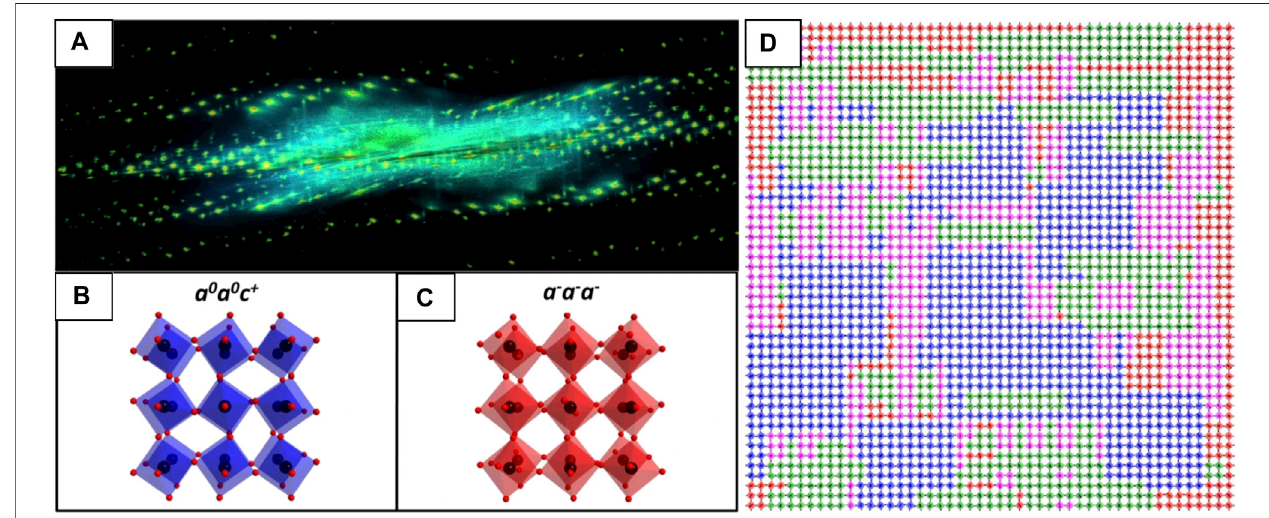
FIGURE 10 | 3D-ED mapping of Bragg and diffuse electron scatter in reciprocal-space to determine TiO 6 octahedral tilt schemes in 85NBT-10BKT-5BT [001] pc ceramic. (A) Reconstruction of the reciprocal-space volume showing intensity from both Bragg and diffuse scattering. (B) Schematic of the in-phase a 0 a 0 c + and (C) antiphase a − a − a − tilt systems. (D) A 2D slice cut from (A) showing three in-phase variants randomly distributed in the antiphase tilted matrix (red, blue, green, and magenta octahedra are tilted according to the a − a − a − , a 0 a 0 c + , a 0 c + a 0 and c + a 0 a 0 tilt systems, respectively. Only the TiO 6 octahedra are displayed. Reproduced from (Neagu and Tai,